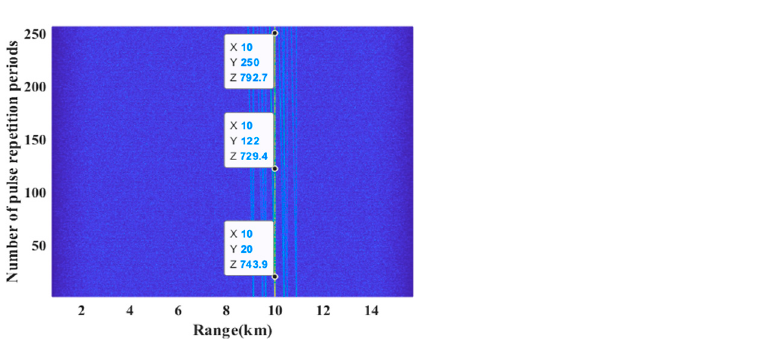
Figure 13. Pulse compression result of multi-period echo signal after compensating based on the improved Keystone algorithm.